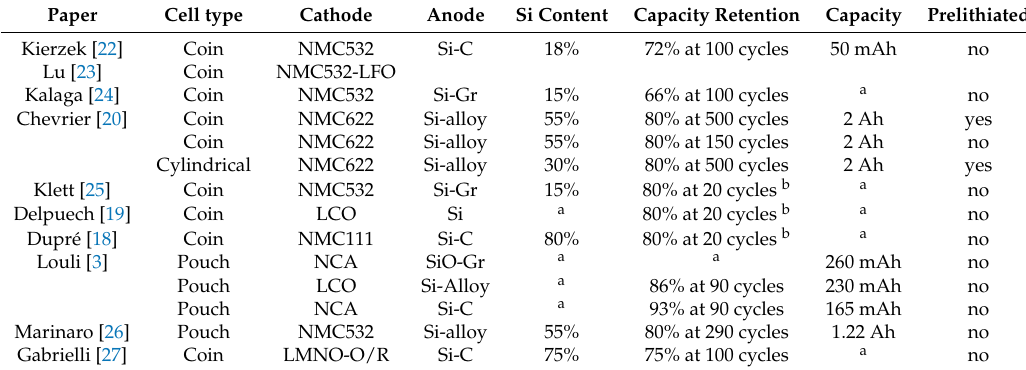
Table 1. Overview of available literature reporting on full Li-ion cells with Si anodes and their